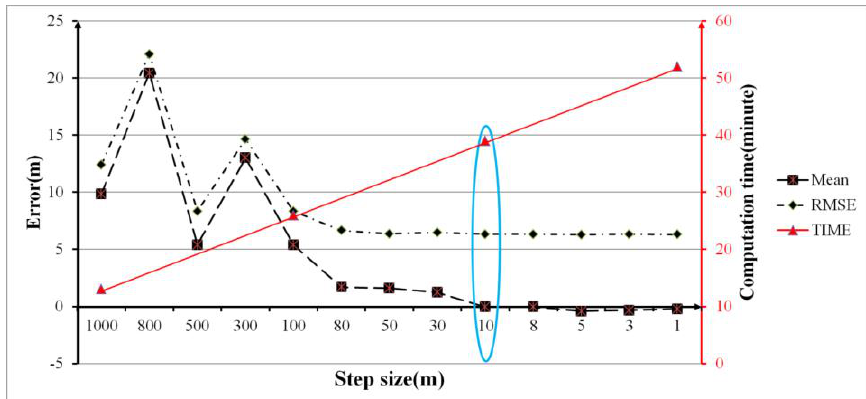
Figure 3. The elevation error and computation time change trend map.